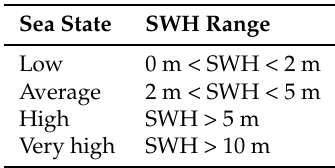
Table 4. Definition of sea